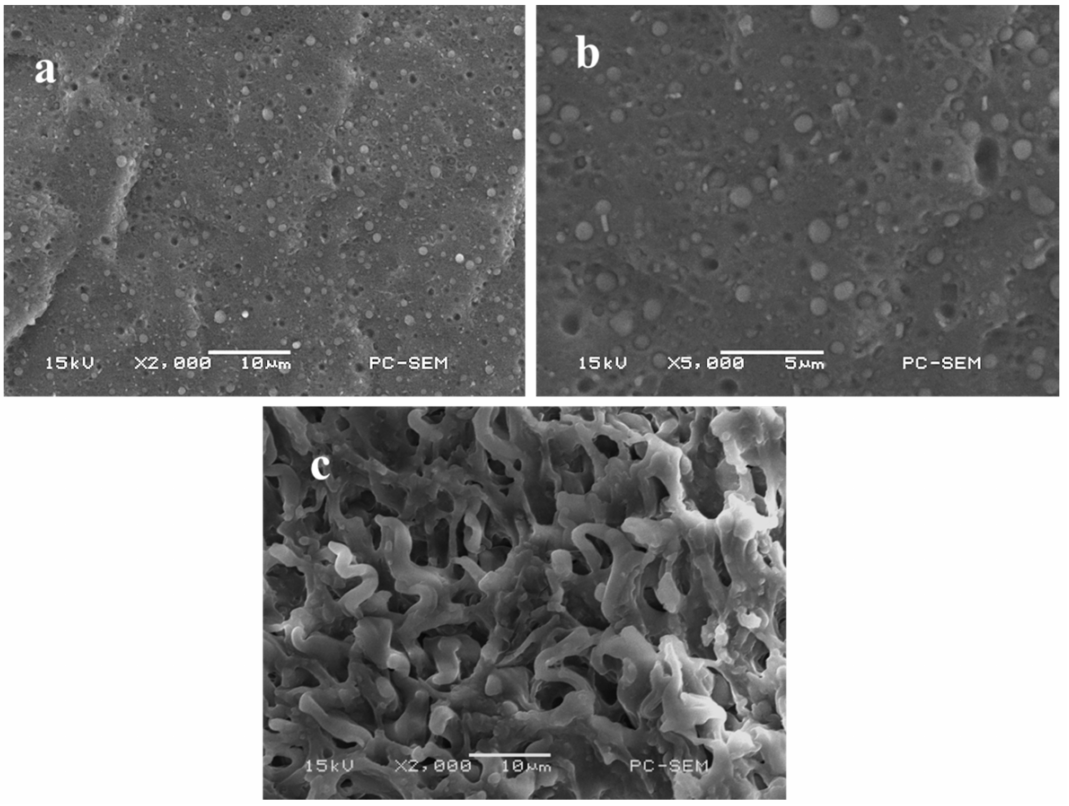
Figure 7. SEM micrographs of the impact fractured surfaces of PPC/TPU blends: ( a ) PPC/10%TPU, ( b ) enlarge view of a, ( c )